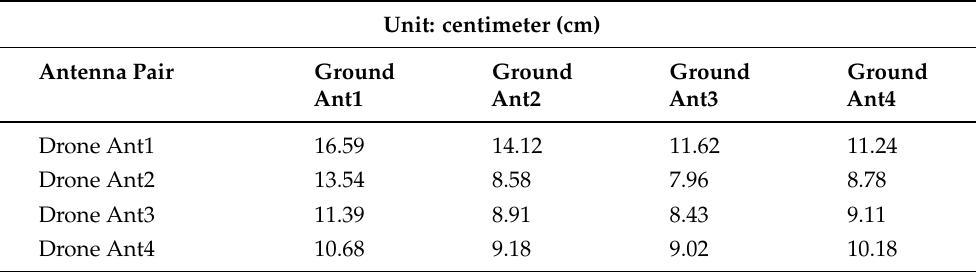
Table 4. Average ranging performance for all antenna pairs in the VTOL test. Unit: centimeter